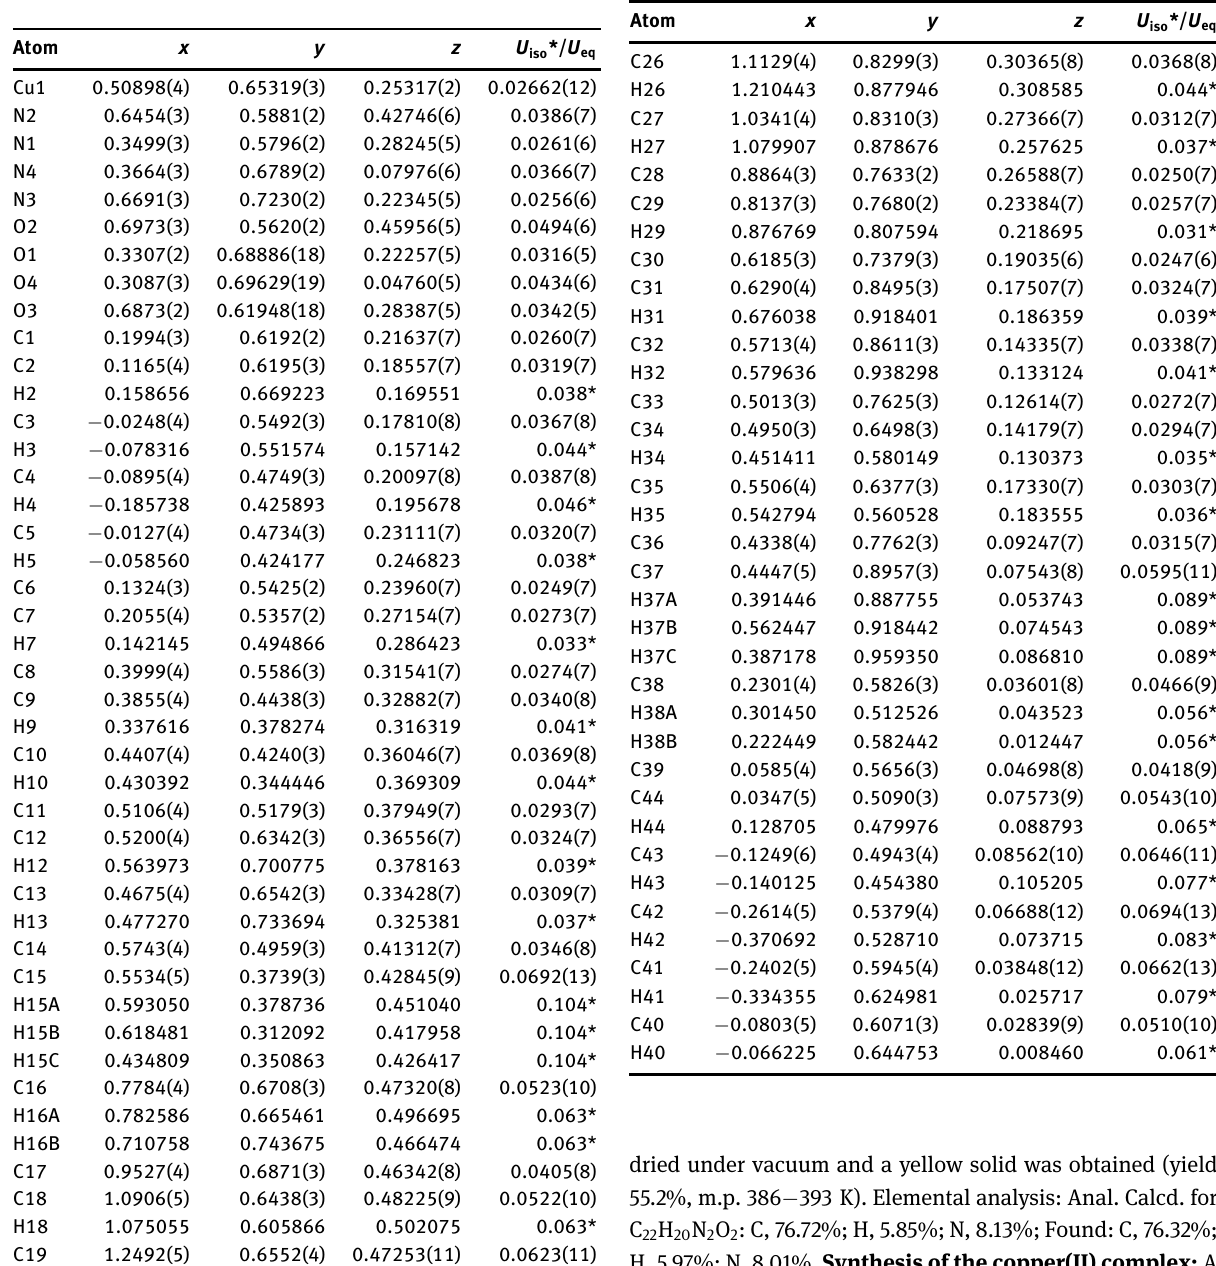
Table 2: Fractional atomic coordinates and isotropic or equivalent isotropic displacement parameters (Å 2